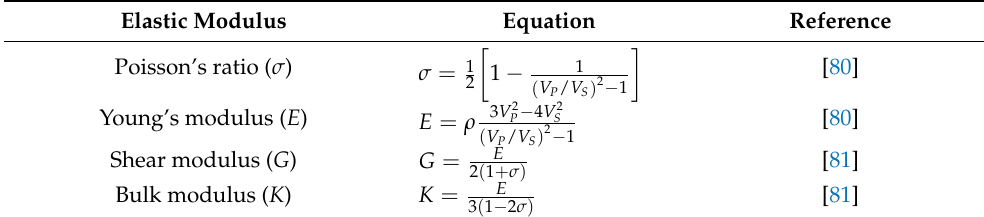
Table 3. Elastic moduli equations.